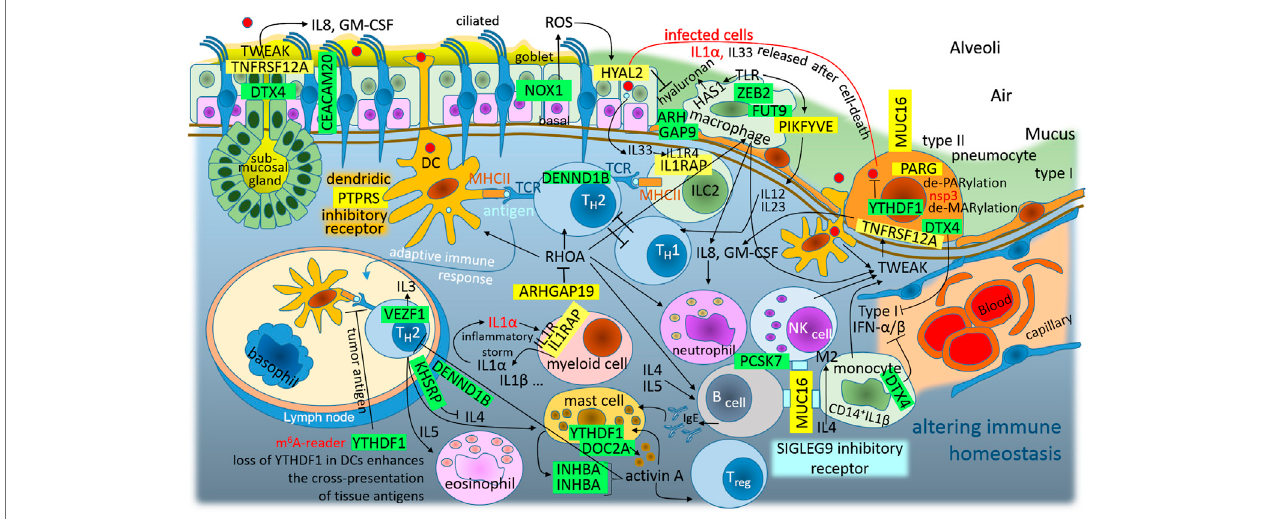
FIGURE 5 | The graphic illustration of “ Altered immune homeostasis is a consequence of SARS-CoV-2 infection. ” Green highlights show the alignments with the complement sequence (post-transcriptionally repressed); yellow highlights show the alignments with the reverse complement sequence (post-transcriptionally promoted). The functions of the identi fi ed genes/proteins by the methodology are summarized in Supplementary Table S1